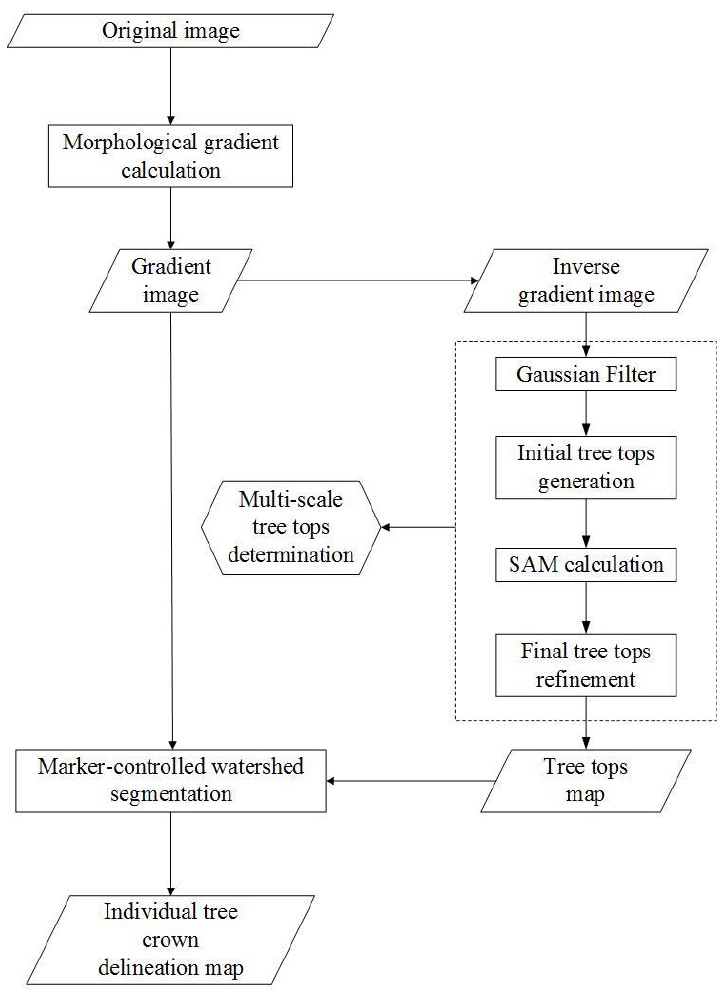
Figure 2. The overall process of the proposed method.